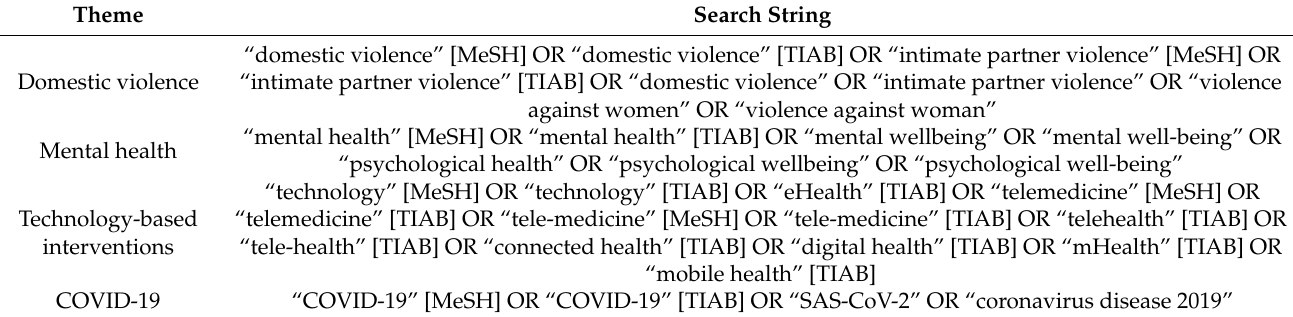
Table 1. Example PubMed search terms.